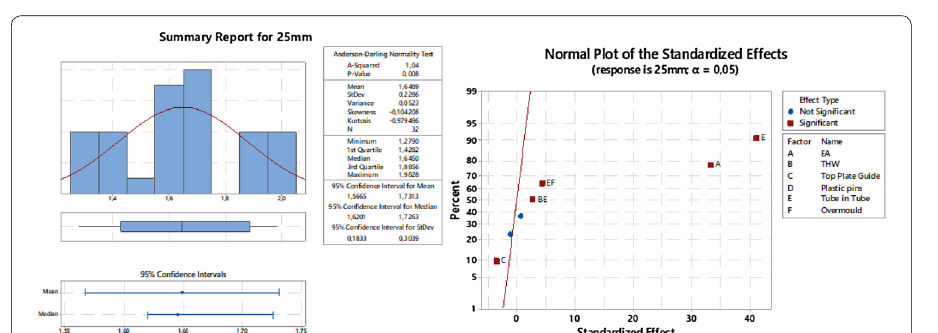
Fig. 15 Summary report for 25 mm